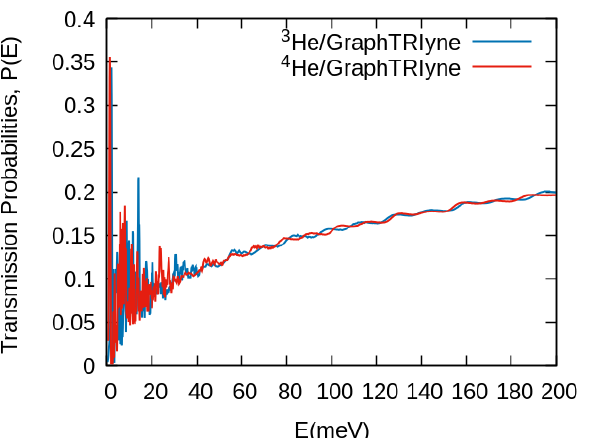
Figure 2. Transmission probabilities of 3 He (blue) and 4 He (red) as a function of the kinetic energy of the atoms through graphtriyne.